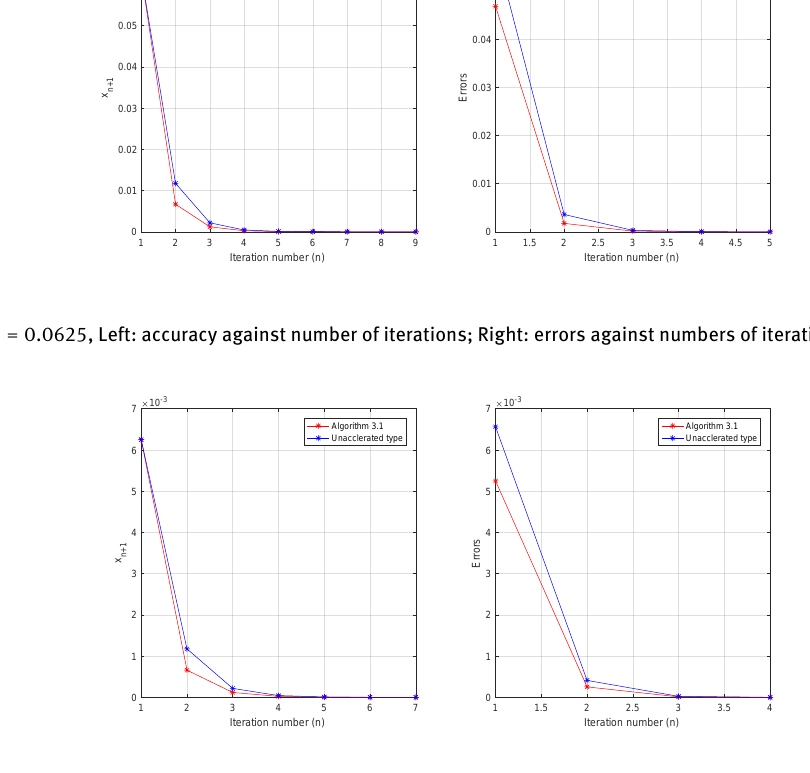
Algorithm 3.1 Unacclerated type